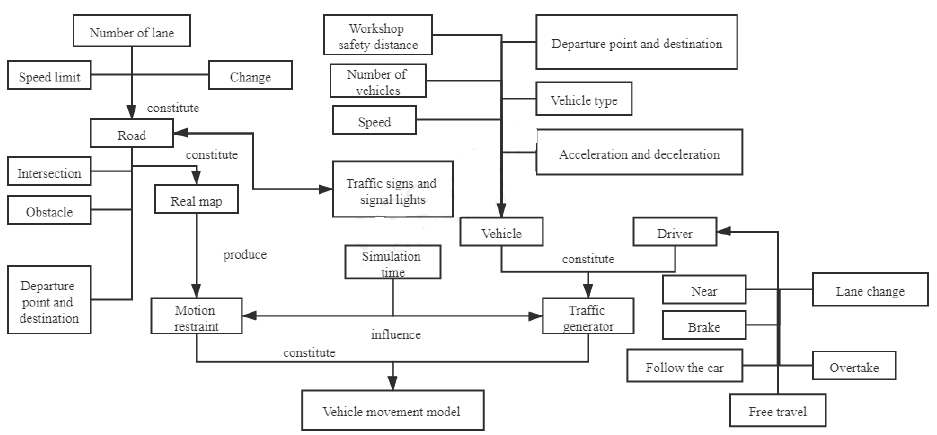
Figure 2. Conceptual framework of real vehicle movement model.